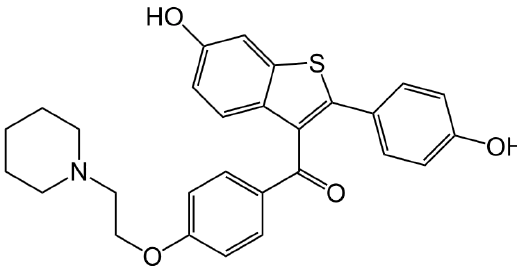
Figure 1. Chemical structure of raloxifene. By Jü - own work, CC0, available online: https://commons.wikimedia.org/w/index.php?curid=16071989. Raloxifene hydrochloride, C 28 H 27 NO 4 S•HCl, has a molecular weight of 510.05 g/mol. IUPAC name: [6-hydroxy-2-(4- hydroxyphenyl)-1-benzothiophen-3-yl]-[4-(2-piperidin-1- ylethoxy)phenyl]methanone;hydrochloride.